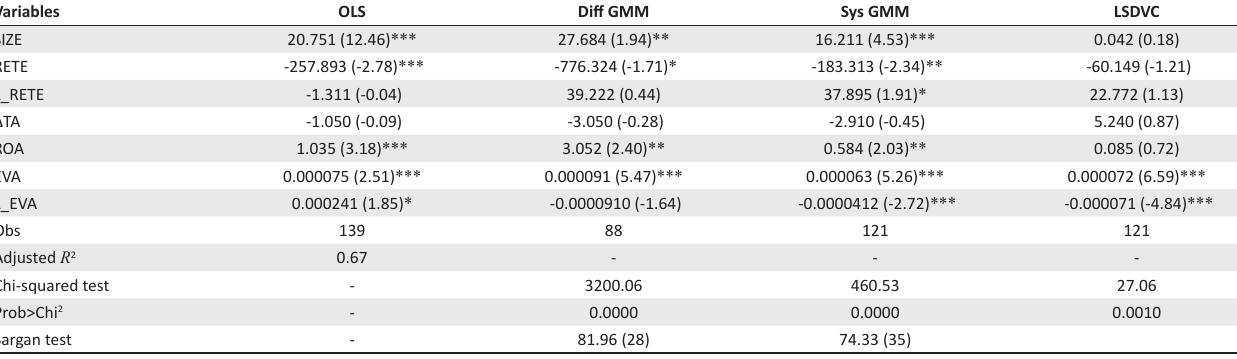
TABLE 4: Regression results for the test of dividend life-cycle hypothesis and determining factors: Panel 3.